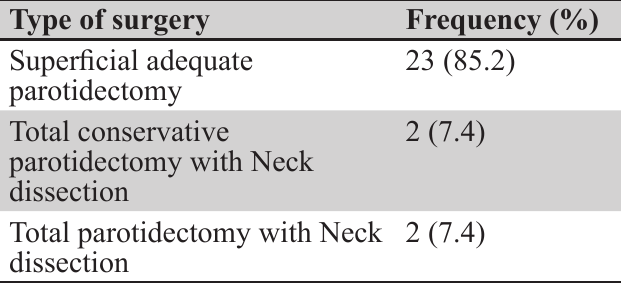
Table 2. Treatment of parotid tumor. Type of